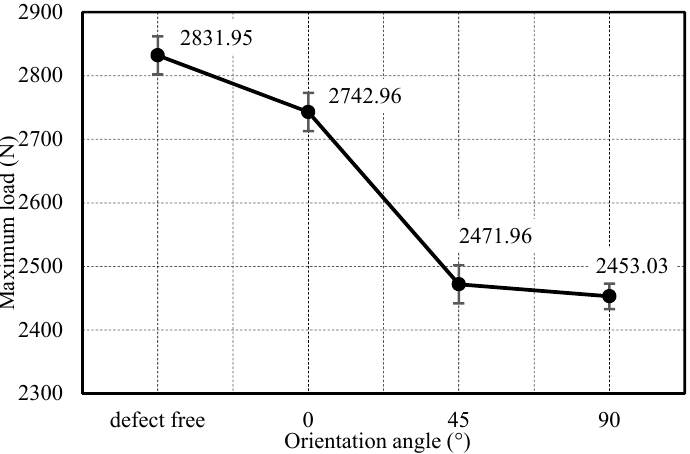
Figure 4. E ff ect of the orientation of the defects on the maximum load [31]. Figure 4. Effect of the orientation of the defects on the maximum load [31]. Figure 4. Effect of the orientation of the defects on the maximum load [31].